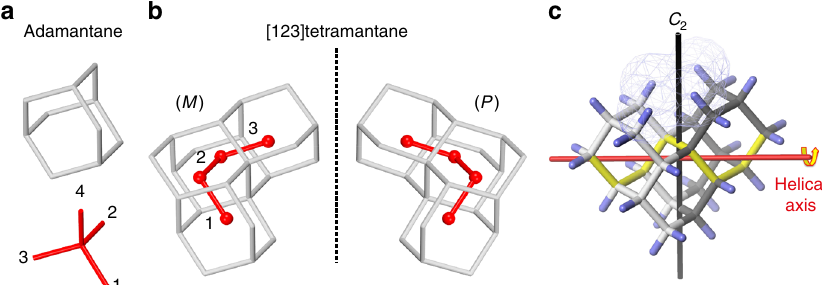
Fig. 1 Structures of adamantane and enantiomers of [123]tetramantane. a Depiction of adamantane. b ( M )-enantiomer and ( P )-enantiomer of [123] tetramantane with hydrogen atoms omitted for clarity (numbers 1 – 4 are used to indicate the directions in Cartesian space of the diamond lattice and four red spheres in molecules indicate the centers of four corresponding adamantane cages). c The ( P )-enantiomer illustrating the helical core (bonds marked in yellow) and close contacts between the hydrogens inside the molecular groove (transparent net